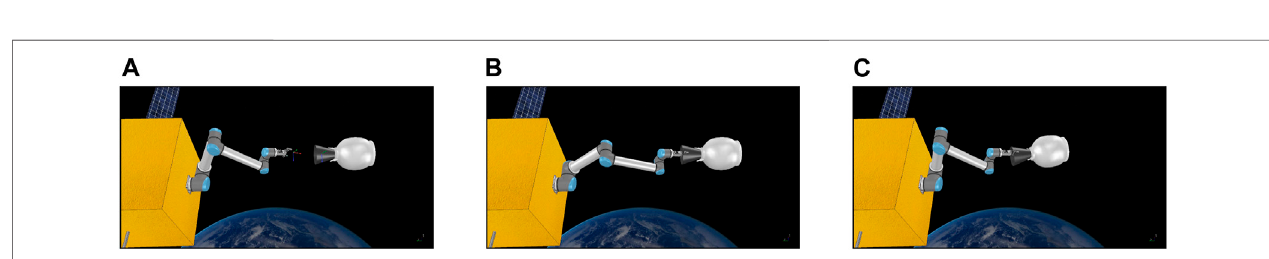
FIGURE 13 | Reaching the approaching pose (A) , grasping pose (B) and fi nal pulling pose (C)